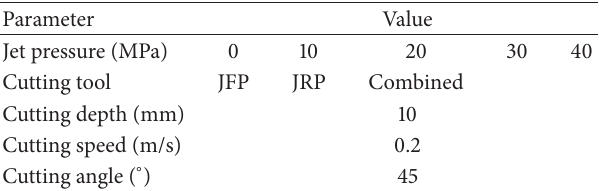
Table 2: Experimental